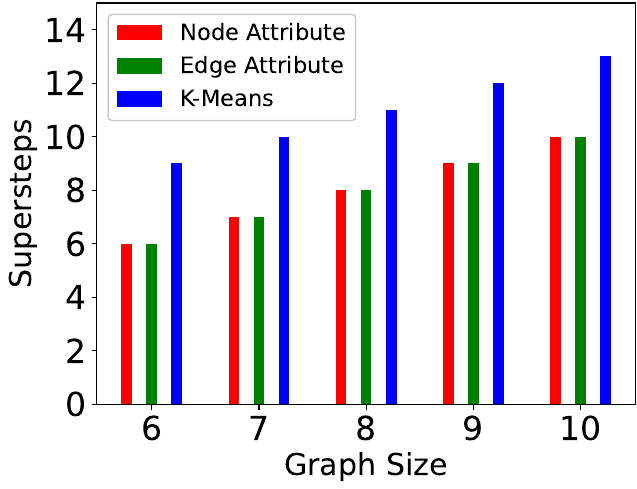
Figure 12. Supersteps in P-TSP.